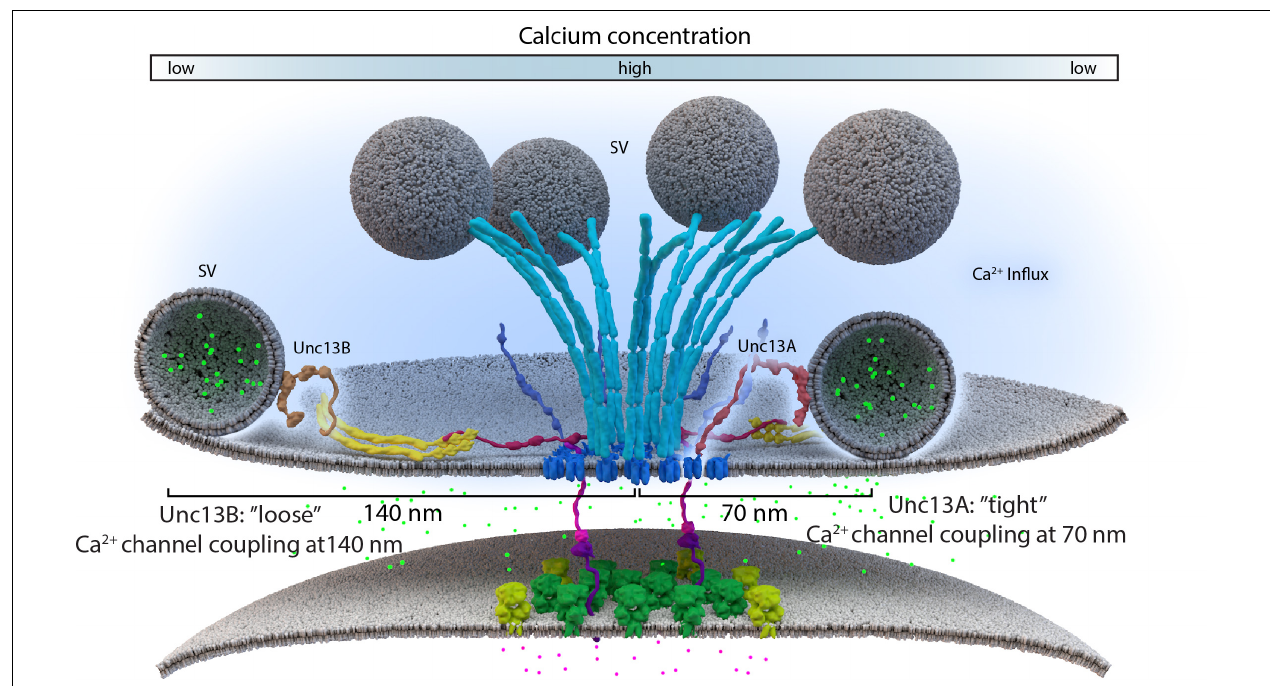
FIGURE 4 | Loose and tight coupling at Drosophila NMJ AZs. A schematic of loose and tight coupling occurring at single NMJ AZs. Loose coupling of SVs, depicted on the left-hand side of the AZ, occurs at low Ca 2 + concentrations, at a rough distance of 140 nm from the AZ center and localize at Unc13B signals that are positioned 120 nm from the center. Tight coupling, depicted on the right-hand side of the AZ, occurs near high Ca 2 + concentrations, that is typically positioned at a 70 nm distance from the AZ center or at Unc13A localizations, which are roughly positioned 50 nm from the AZ